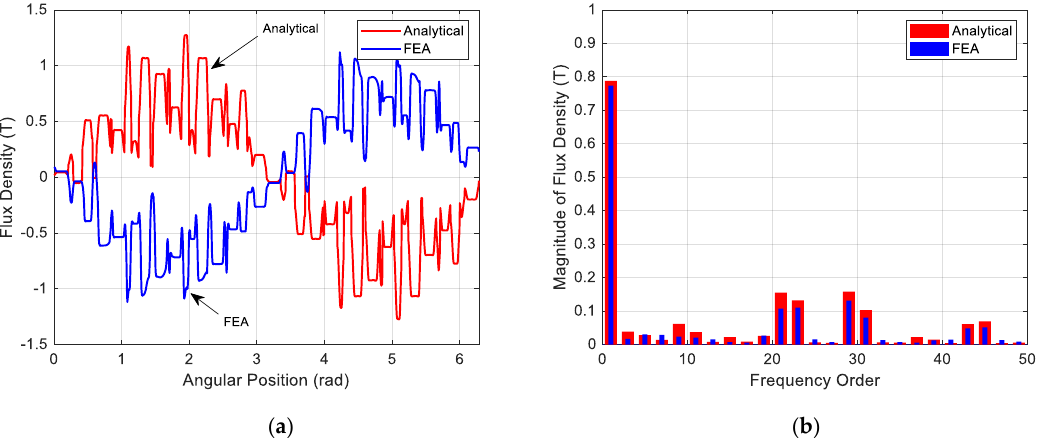
Figure 8. ( a ) Final air gap flux density for motor operating under load condition; flux density distribution ( left )—blue line inverted, ( b ) frequency spectrum ( right ).